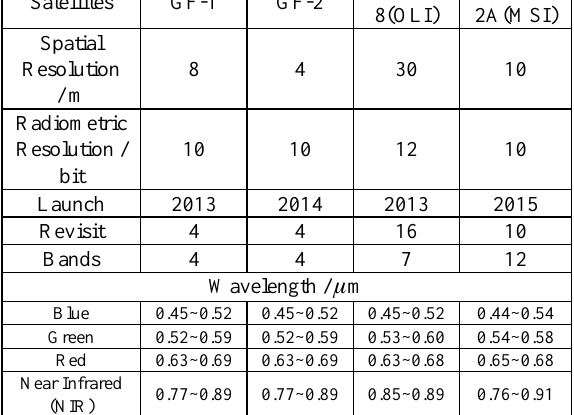
Table 2. Parameters of four optical satellites.